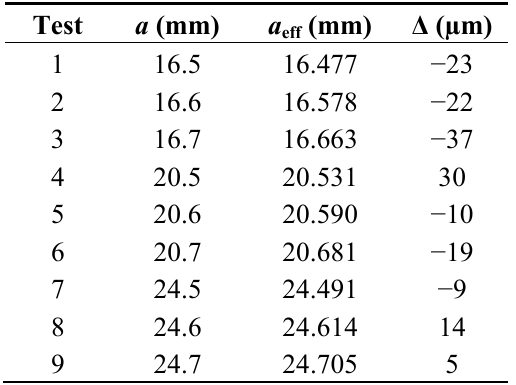
Table 1. Results of the metrological analysis.